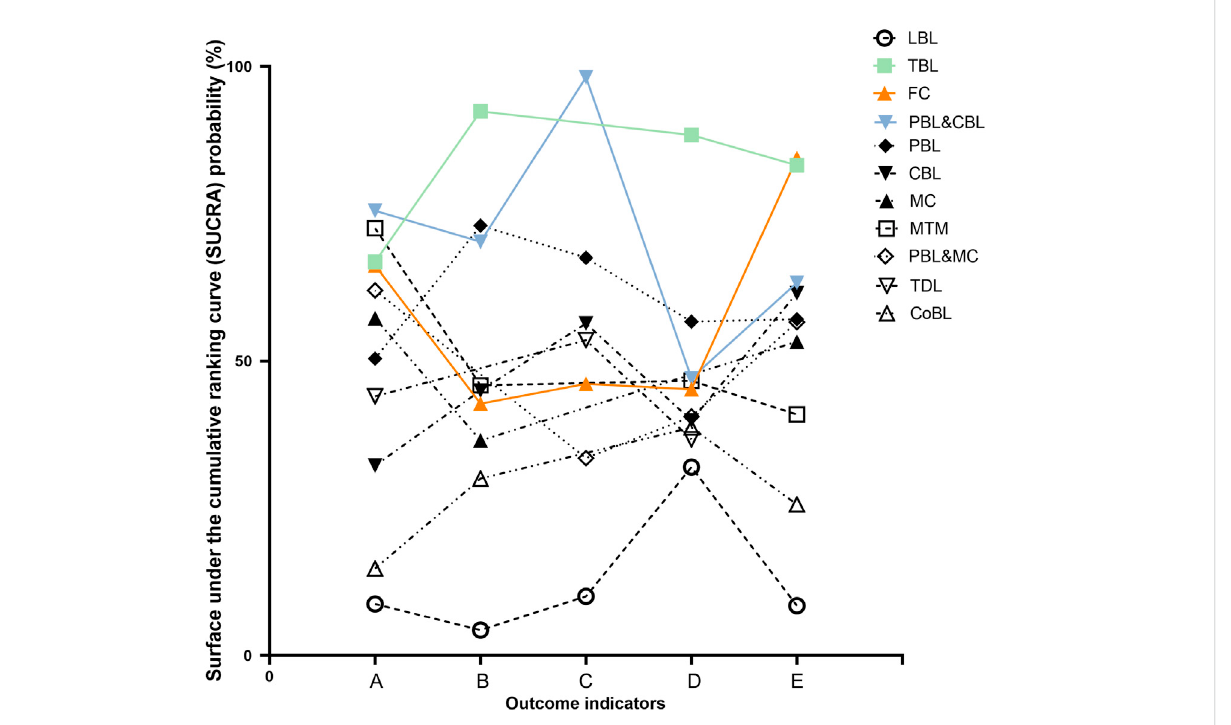
FIGURE 8 SUCRA probability of different teaching method in the outcome indicators. (A) The theoretical test score. (B) The experimental test score. (C) The subjective test score. (D) The satisfaction score. (E) The proportion of